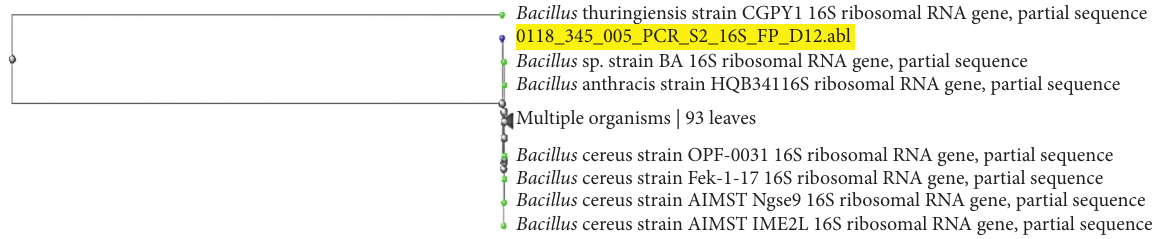
Figure 7: Phylogenetic tree based on partial sequence of 16S ribosomal RNA gene for Sample S2 (highlighted yellow color) showed that the amylase-producing bacteria was Bacillus cereus based on the first five identities and phylogenic analysis showed also proximity to Bacillus thuringiensis . Table 1: Partial purification steps of α- amylase enzyme from Bacillus cereus.